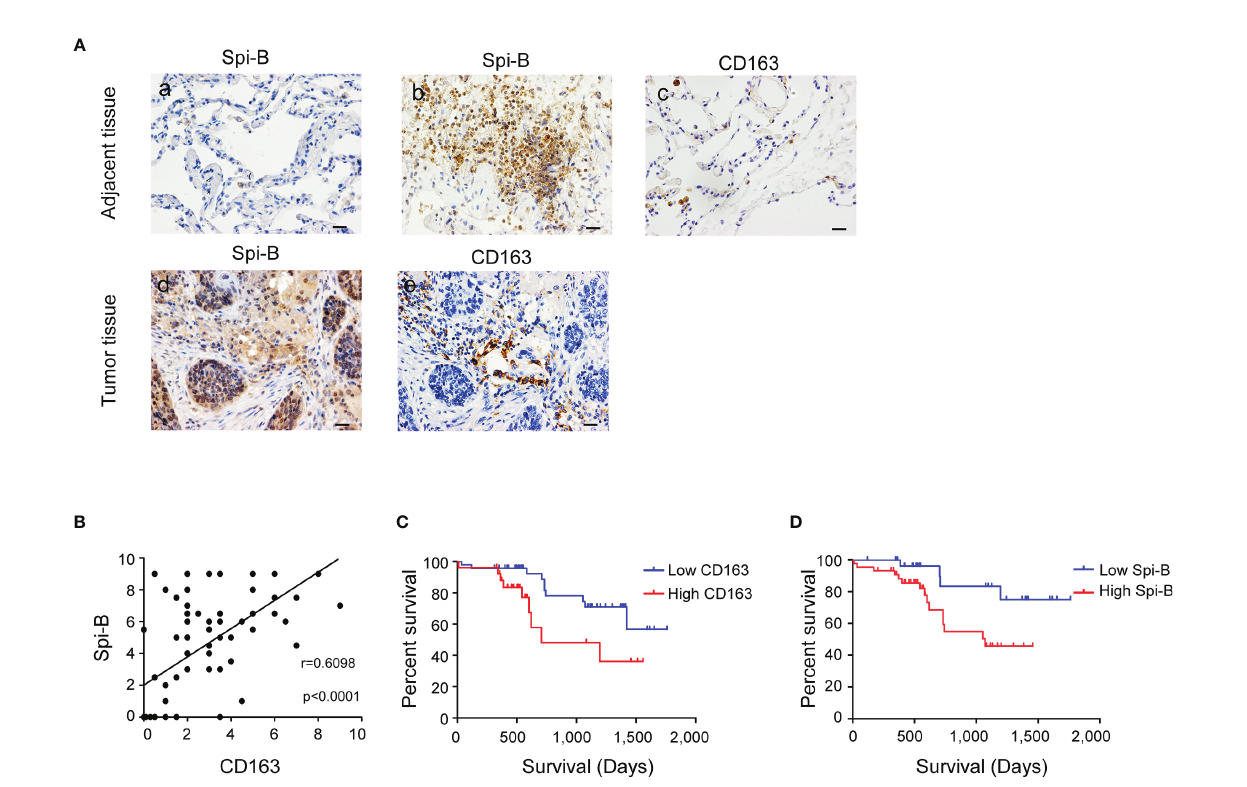
FIGURE 3 | Spi-B expression positively correlates with the proportion of CD163 + macrophages in human lung cancer tissues. (A) Immunostaining of human CD163 and Spi-B in paraf fi n-embedded lung tissues using phase-contrast microscopy (400×). Representative images show a lack of Spi-B staining in normal lung epithelial cells (a), but positive Spi-B staining in lymphocytes (b) and positive CD163 staining in alveolar macrophages (c). In lung cancer tissues, CD163-expressing TAMs surrounded and in fi ltrated cancer masses of strong Spi-B staining (d, e). Scale bars, 20 µm. (B) Semiquantitative scoring was performed. CD163 scores were associated with Spi-B scores (r = 0.6098, P < 0.0001). (C) Kaplan-Meier survival rates for 73 subjects with low (staining scores ≤ 3, n = 47, blue line) versus high (staining scores > 3, n = 26, red line) CD163 expression were compared (P = 0.0307). (D) Kaplan-Meier survival rates for 73 subjects with low (staining scores < 4, n = 29, blue line) versus high (staining scores ≥ 4, n = 44, red line) Spi-B expression were compared (P =